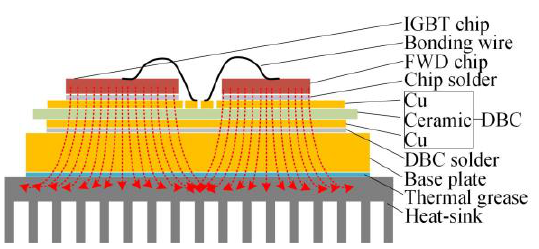
Figure 22. Traction converter 3D structure.